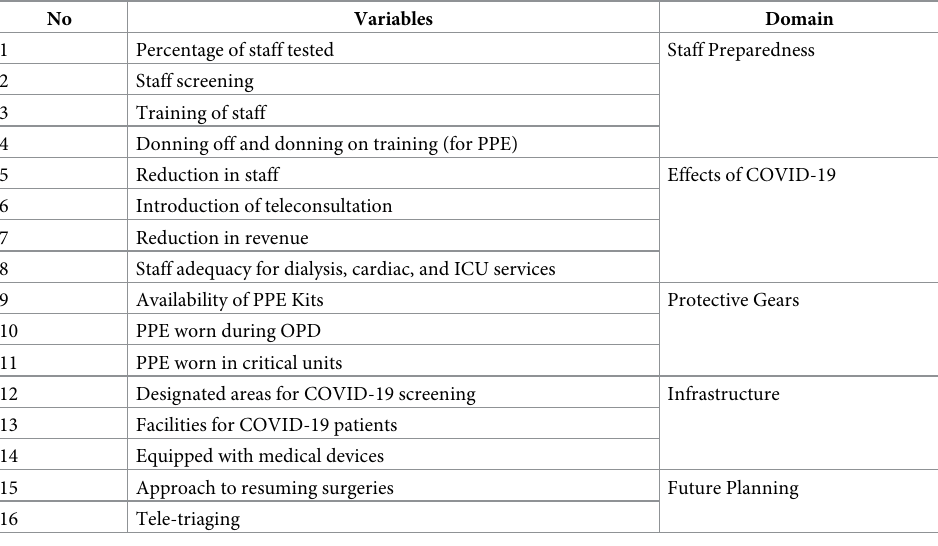
Table 1. Domains and variables of the Hospital Preparedness Index,